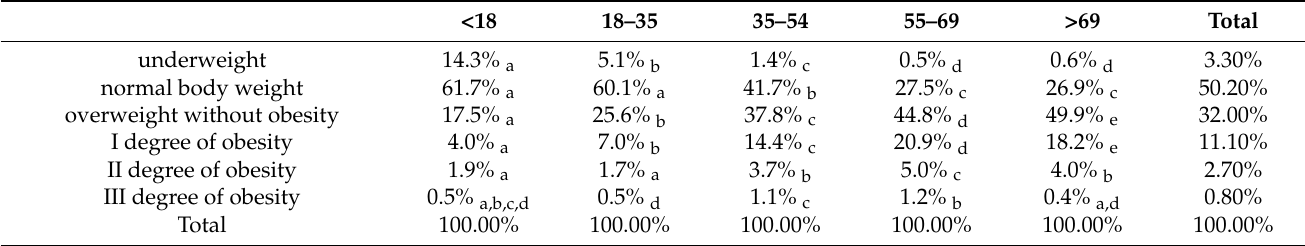
Table 4. Relationship between BMI and patients’ age; data presented as percentage of age group 1 .